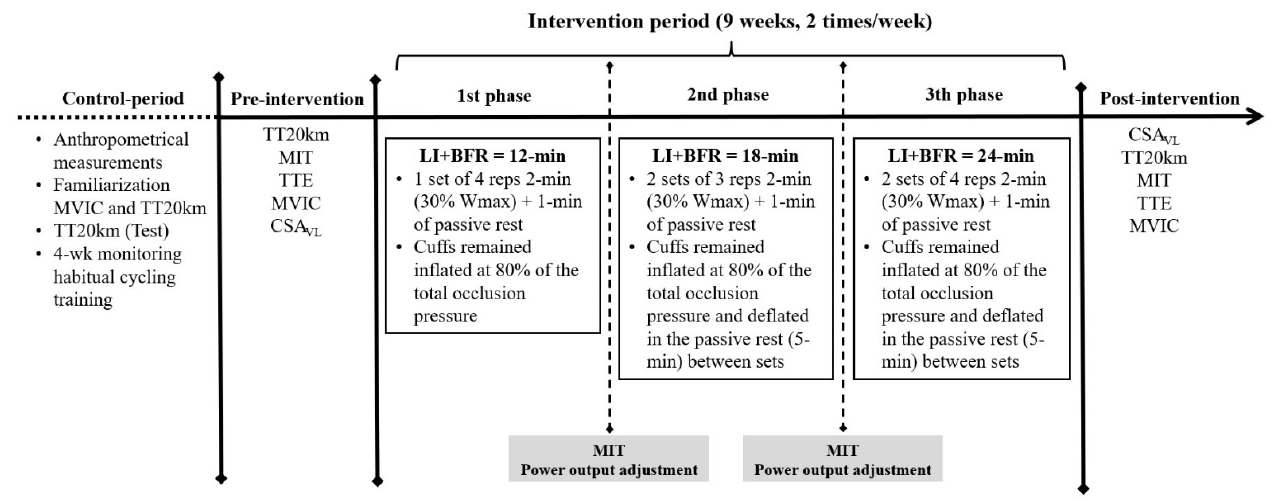
Figure 1. Experimental